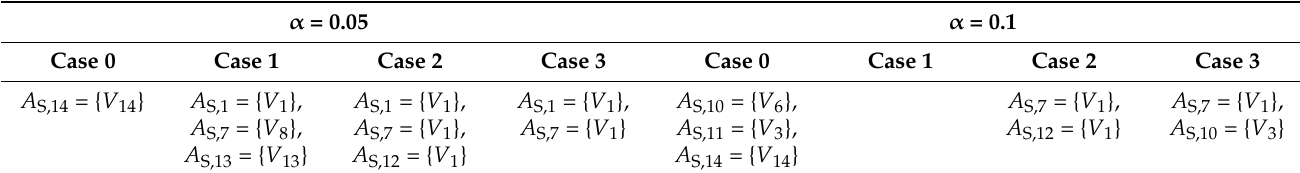
Table 20. One-Element Influence Sets for Considered Study Cases when α = 0.05, 0.1. α = 0.05 α = 0.1